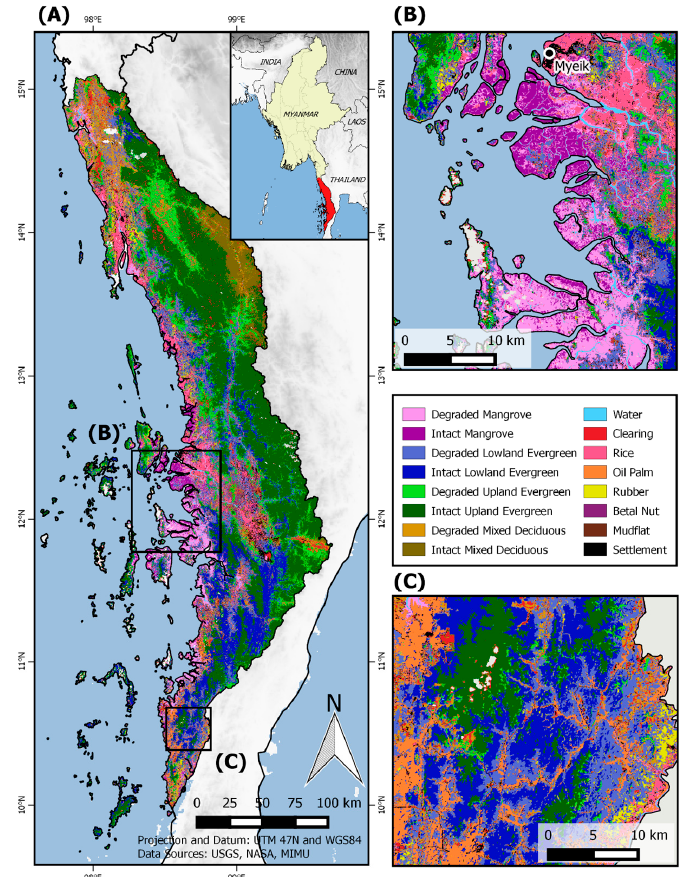
Figure 1. Land cover classification for Myanmar’s Tanintharyi Region in 2016 ( A ); Mangrove degradation south of the city of Myeik ( B ); Oil palm plantation development and lowland evergreen forest in Tanintharyi’s Kawtaung District ( C ).